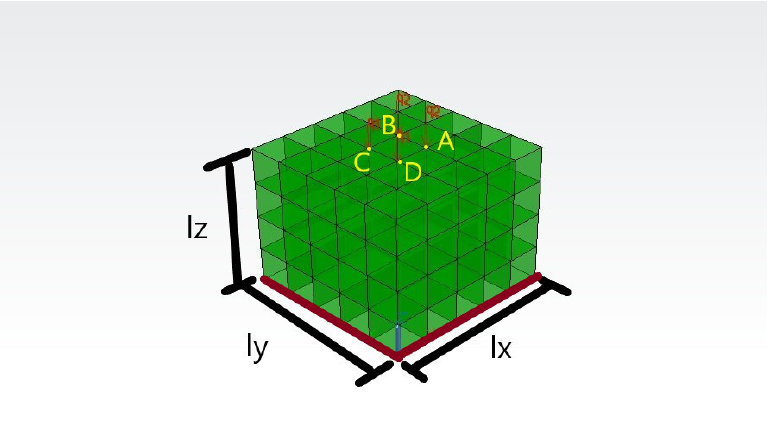
Figure 2. The soil domain and the loads applied for non oblique loading, where l x = 5 m , l y = 5 m , l z = 4 m and q 1 = max ( q 1 , q 2 , q 3 , q 4 ) , q 2 = min ( q 1 , q 2 , q 3 , q 4 ) . The lines colored in maroon indicate the boundary conditions and the points considered as fixed u x ( z = h ) = u y ( z = h ) = u z ( z = h ) = 0 . The validity and the reliability of the proposed methodology are analyzed